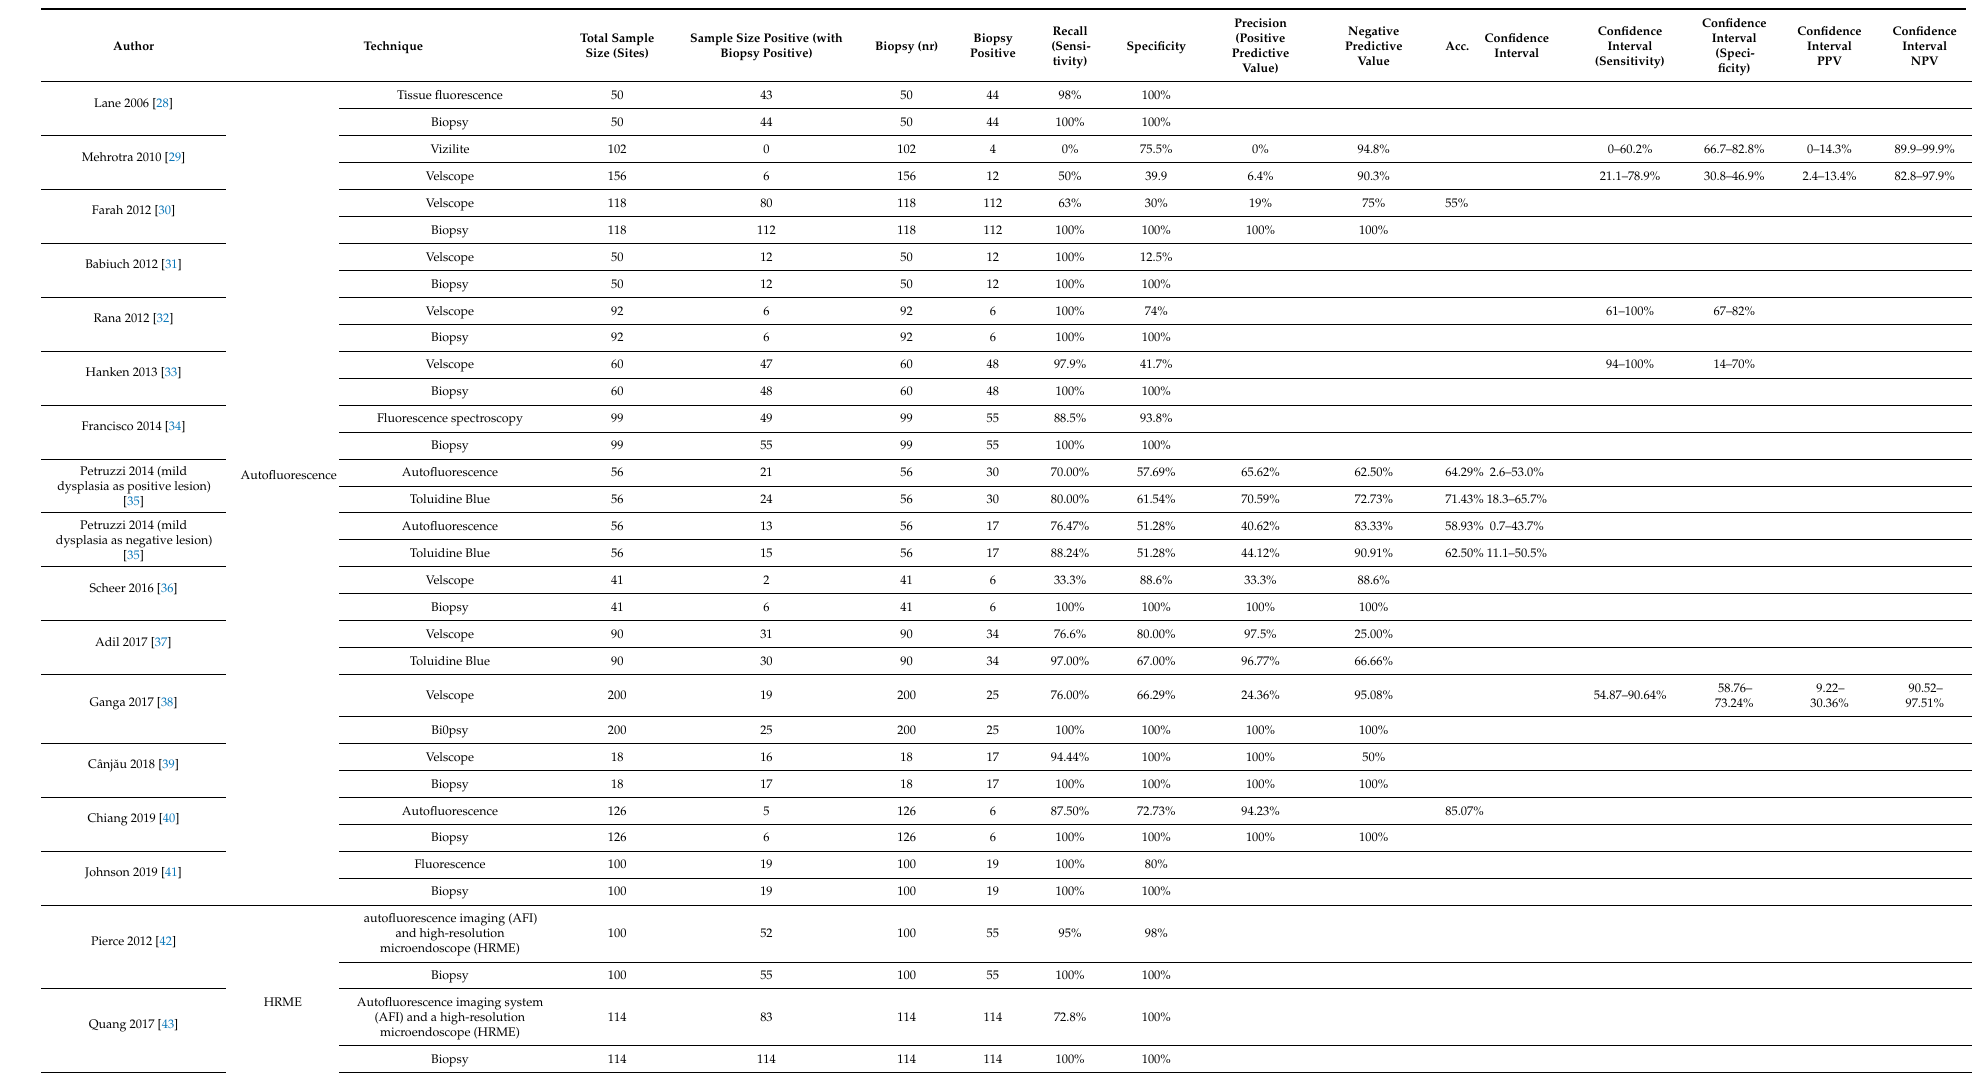
Table 1. Characteristics of included